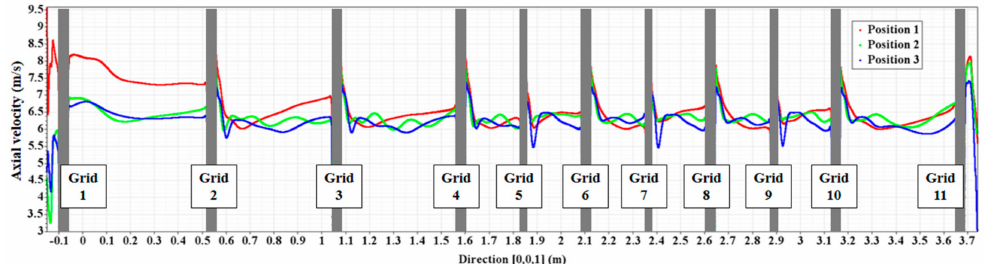
Figure 15. Change of the axial velocity along the flow